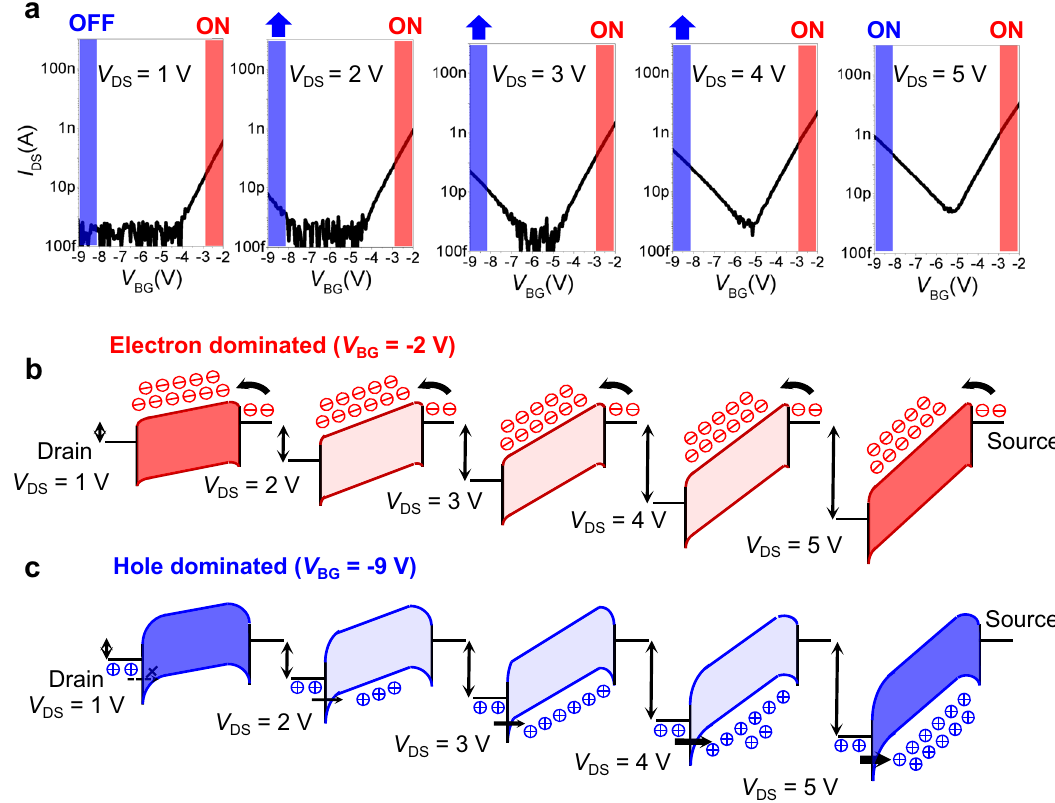
Fig. 2 The mechanism of switchable logic functions by voltage control. a The transfer characteristic curves of I DS - V BG at different V DS from 1 V to 5 V. The blue shaded area represents the hole conduction dominated region ( V BG = − 9V), the red shaded area represents the electron conduction dominated region ( V BG = − 2V) (The V S is fi xed to zero voltage, adjust V DS only by changing V D ). b The band diagram of the electron-dominated region under different V DS (The height of the black arrow represents V DS ). The electrons are injected into the channel across the barrier between the source and the channel. V DS has little effect on the conduction current. c The band diagram of the hole-dominated region under different V DS . The holes tunnel through the barrier between the drain and the channel and inject into the channel. As the V DS increases from 1 V to 5 V, the tunnelling ef fi ciency increases, increasing the hole